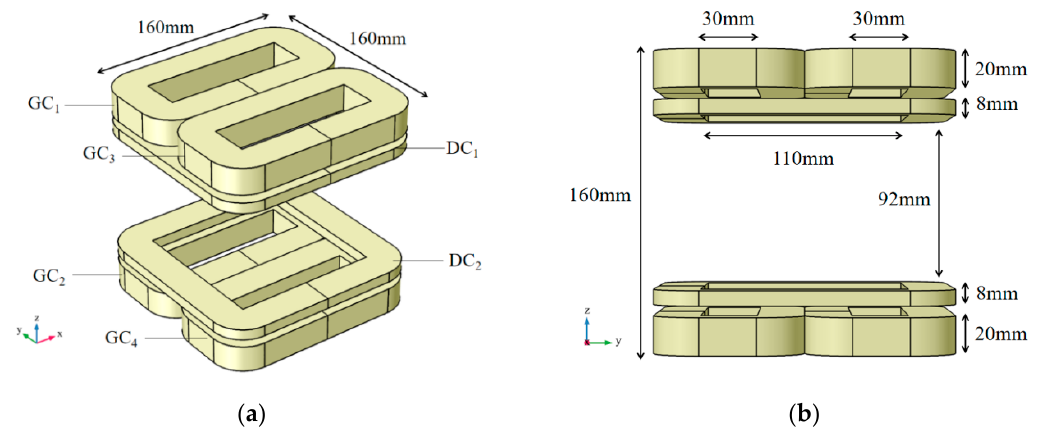
Figure 1. Schematic diagram of combined coil structure. ( a ) 3D view; ( b ) y-z view.